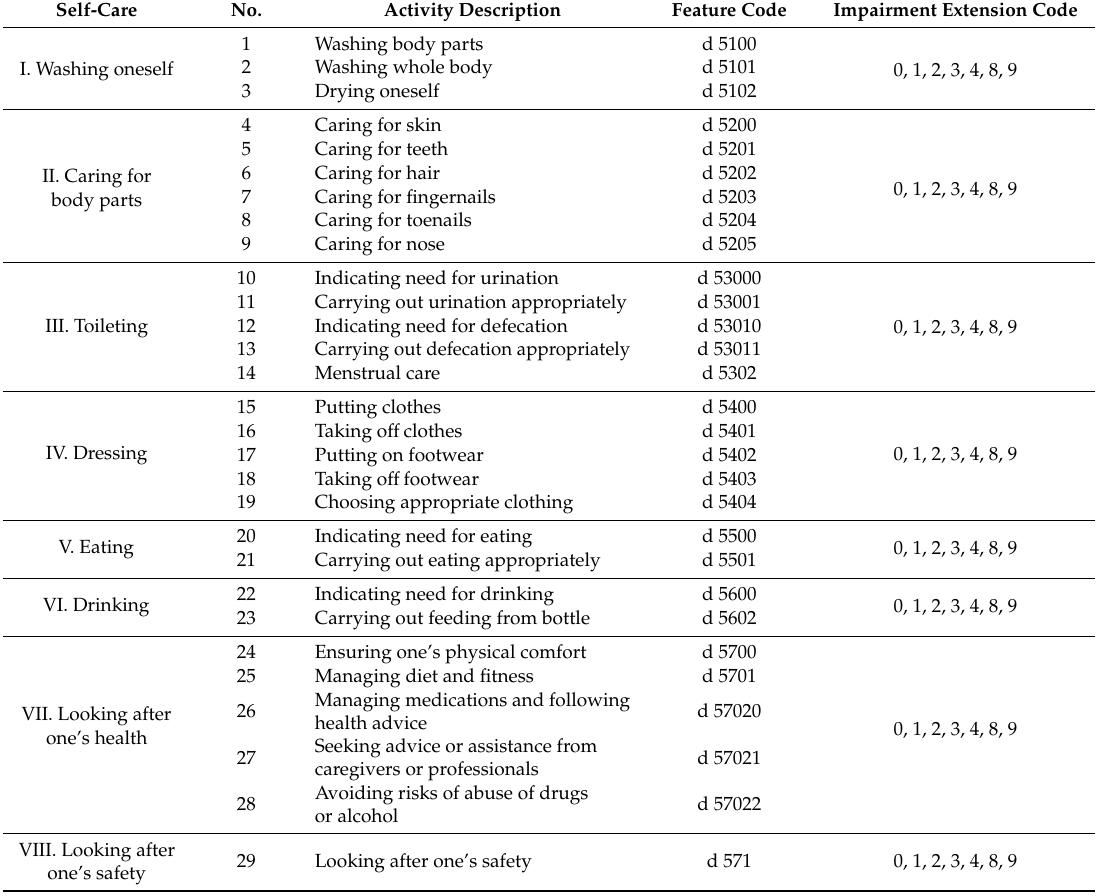
Table 2. Self-care activity codes of the self-care activities based on ICF-CY (SCADI) dataset [4]. Self-Care